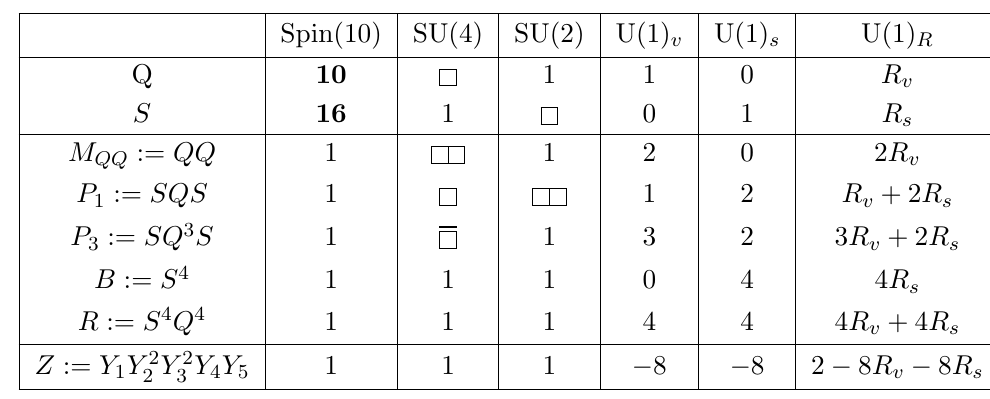
Table 10 . 3d N = 2 Spin(10) theory with ( N v ; N s ; N s 0 ) = (6 ; 1 ; 0).